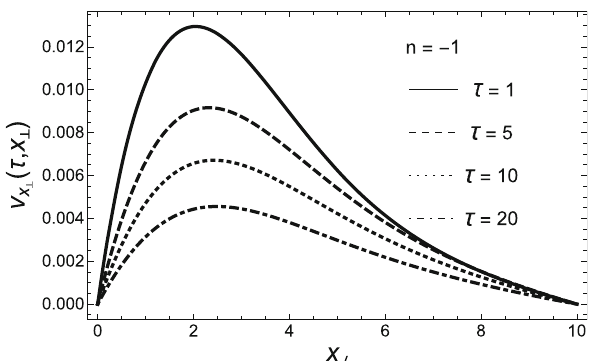
Fig. 3 v x ⊥ as a function of x ⊥ for different values of τ